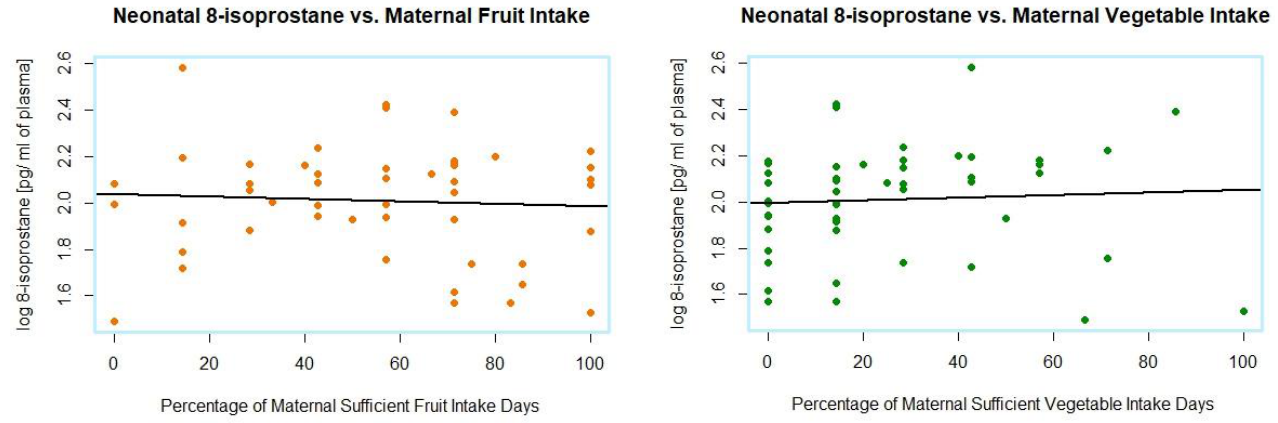
Figure 6. Relationships between neonatal plasma concentrations of 8-isoprostane and maternal fruit and vegetable intake.